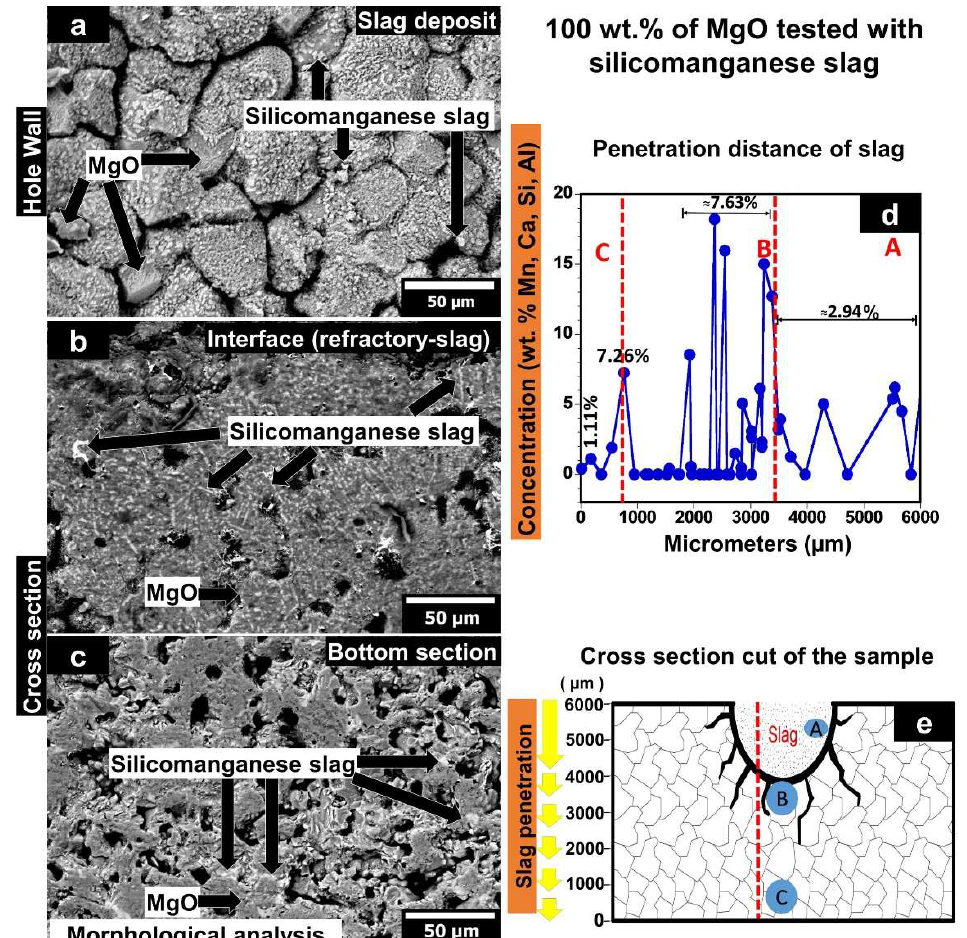
Figure 7. ( a – c ) SEM images of 100 wt.% MgO sample sintered at 1650 °C and chemically attacked with silicomanganese slag. ( d ) The concentration of silicomanganese slag elements as a function of the penetration distance. ( e ) Schematic representation of the cross-cut section of the sample used for chemical analysis.